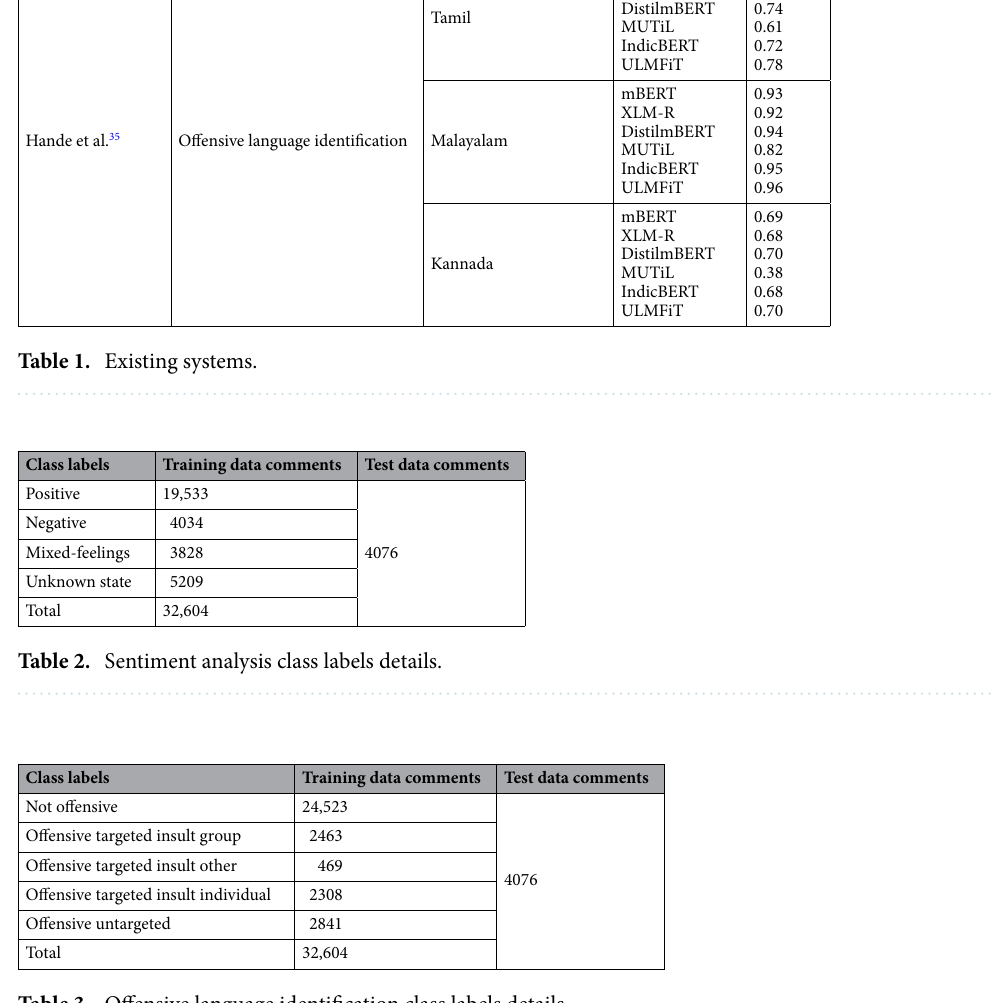
Table 3. Offensive language identification class labels